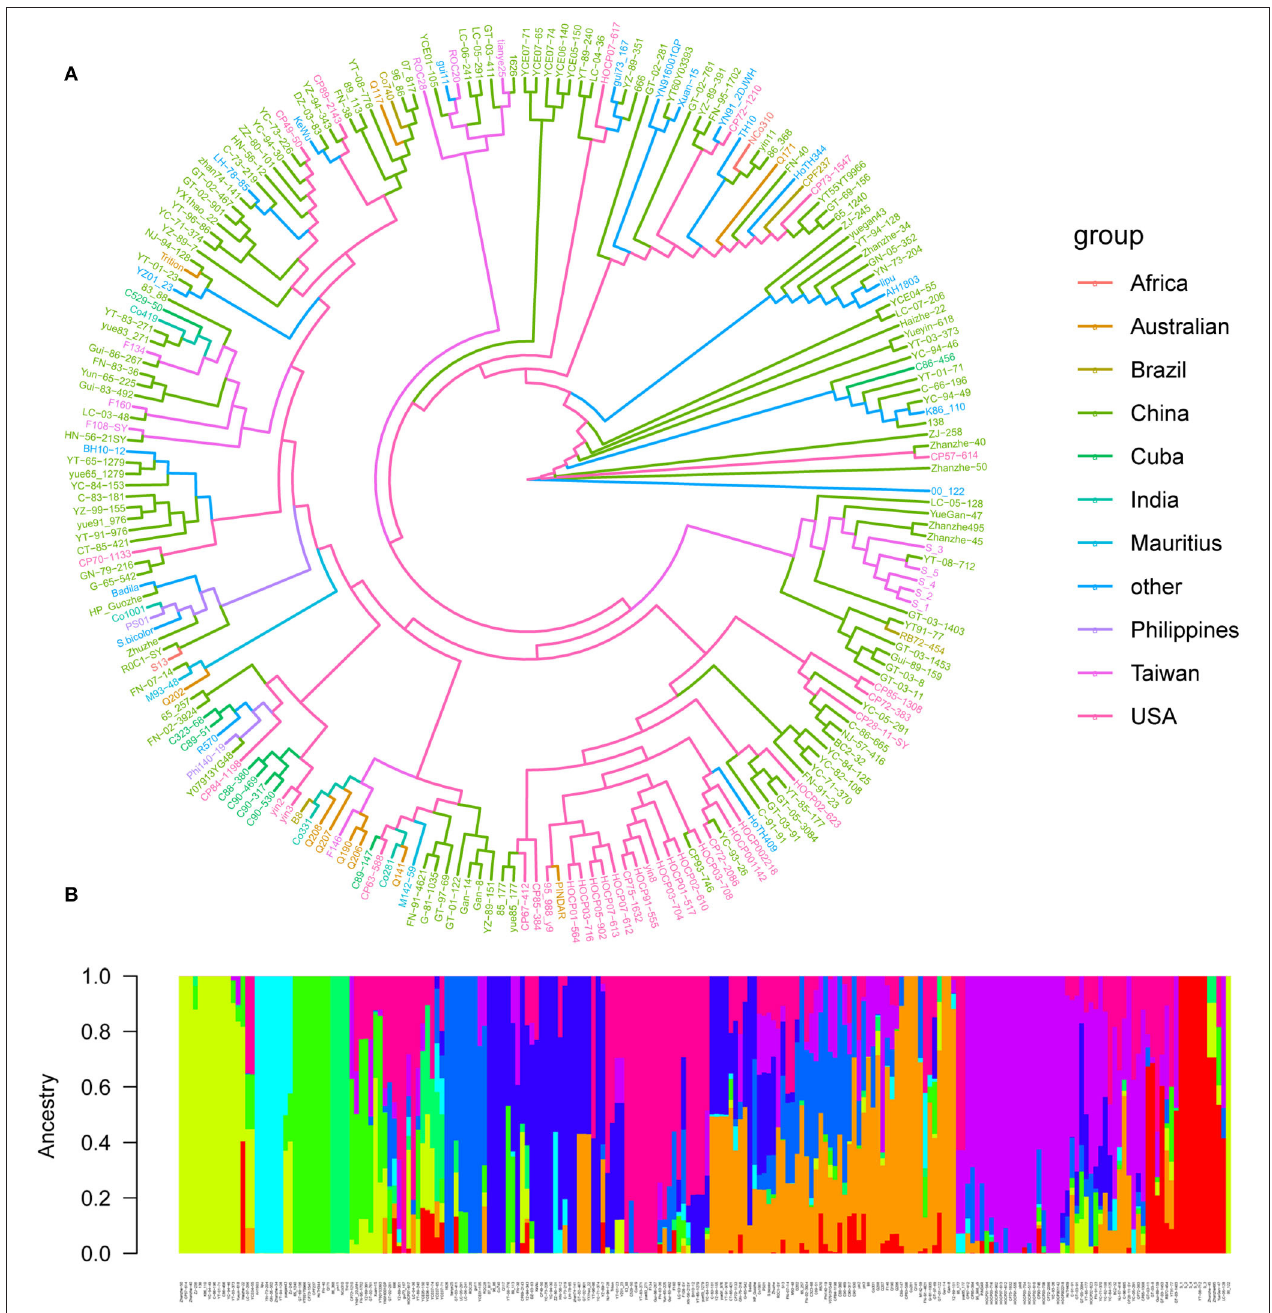
FIGURE 4 | Population structure of 216 sugarcane core parents and their derived lines. (A) Phylogenetic tree of 216 sugarcane core parents and their derived lines. Each distinct group was marked with a specific color; (B) subpopulations inferred using structure.